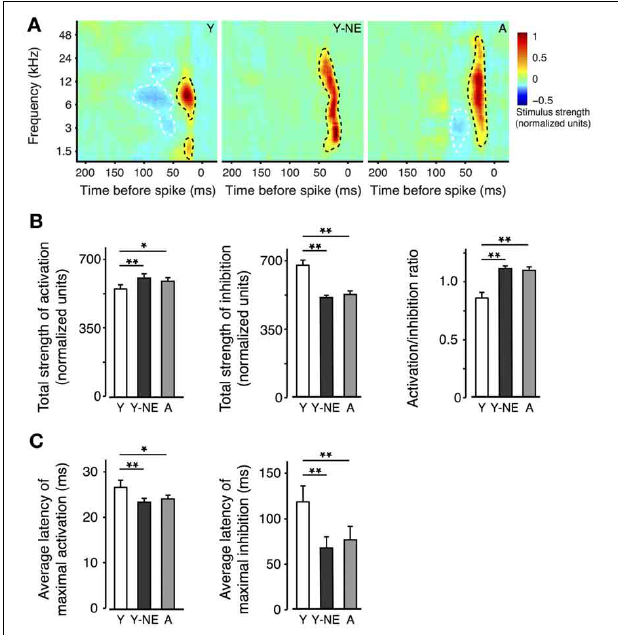
FIGURE 2 | Impact of noise exposure on spectro-temporal interactions. (A) Representative spatio-temporal receptive fields (STRFs) obtained for single neurons in A1 in Y, Y-NE, and A groups. Positive (red, black dotted line) regions of the STRF indicate that stimulus energy at that frequency and time tended to increase the neuron’s firing rate, and negative (blue, white dotted line) regions indicate where the stimulus envelope induced a decrease in firing rate. Note the smaller and shallower inhibitory areas in the aged noise-exposed and aged groups. (B) Total average strengths of activation, inhibition, and activation/inhibition ratio of the STRFs recorded. Note the increase in the activation/inhibition ratio in the Y-NE and A groups. (C) Average latency to maximal activation and inhibition in all experimental groups. (Y, number of STRFs recorded = 275; Y-NE = 208; A = 245). ∗ p < 0 . 05, ∗∗ p < 0 . 01: t -test.